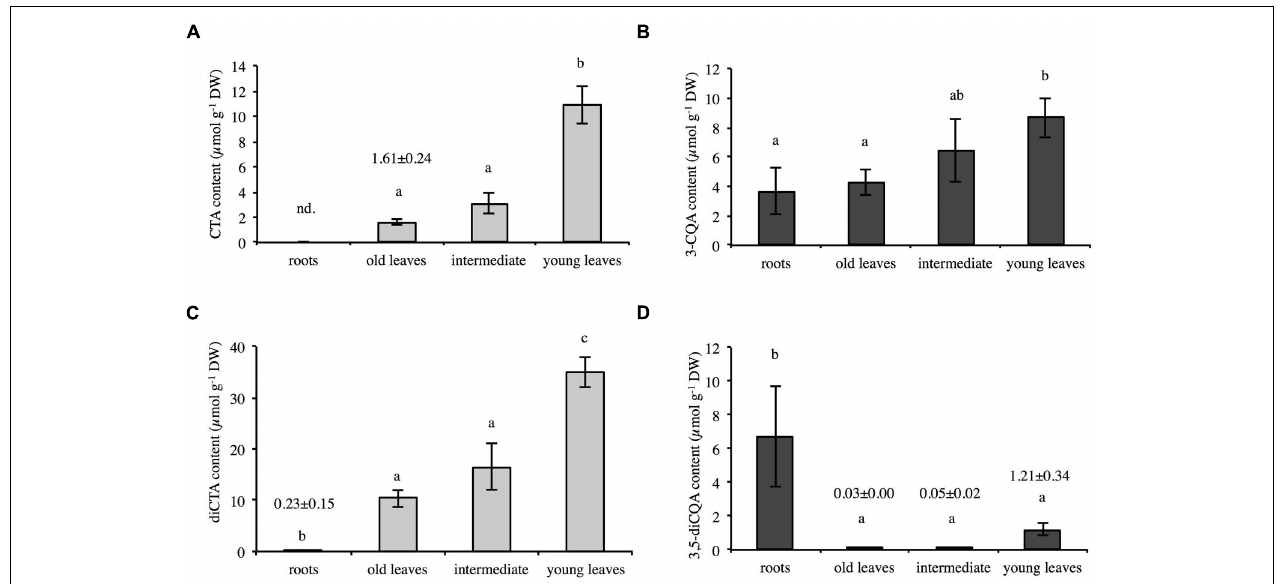
FIGURE 3 | Contents of CTA (A), 3-CQA (B), diCTA (C), and 3,5-diCQA (D) in roots and leaves (different ages) of chicory seedlings. Methanolic extracts of roots or leaves of 4-weeks-old seedlings were analyzed by HPLC. The data represent the mean values ( ± SD) of four biologically independent experiments. Different letters in the same histogram indicate significant differences detected using ANOVA ( P < 0.05). nd, not detected.